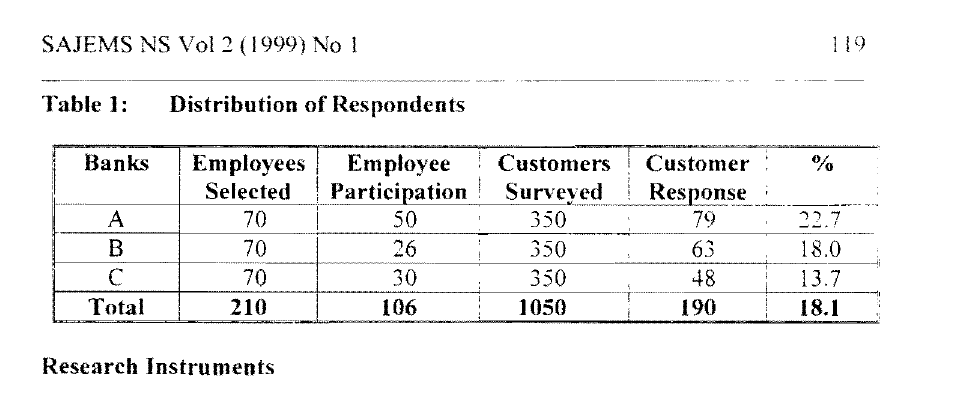
Table 1: Distribution of